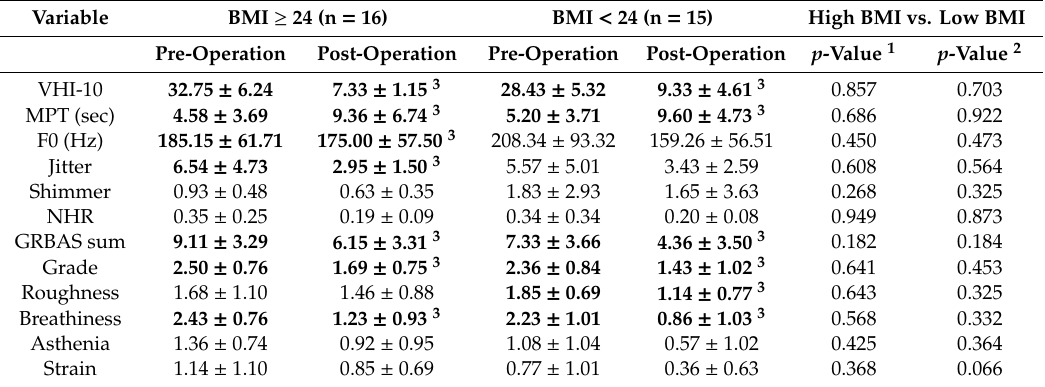
Table 5. Subgroup comparisons of parameters between the BMI ≥ 24 and BMI < 24 subgroups.